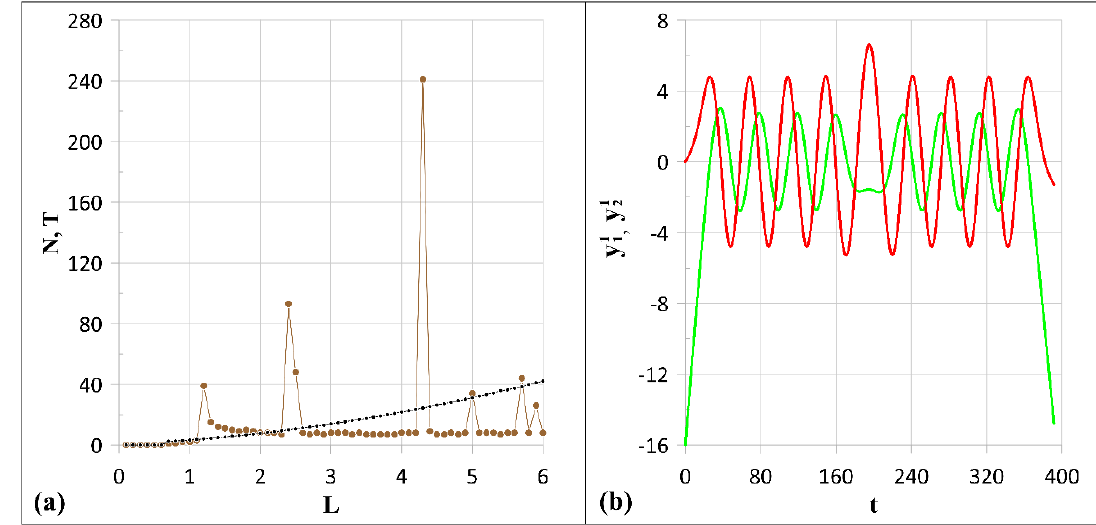
Figure 5. Some properties of the finite motion of vortices at 𝛬 21 𝛬 11 ⁄ = 1 2⁄ : ( a ) The average period T (violet line) of the vortex structure rotation and the number of rotations N (brown line) of the vortices in the closed region vs. the distance L . The curves are plotted according to calculations carried out at values of L with a step of 0.1 inside the interval [0.1; 6.0]. ( b ) Dependences of y -coordinates for the cyclone of the upper layer (red line) and for the cyclone of the middle layer (green line) at L = 4.8 in a time interval slightly exceeding the interval of finite motion of the vortices t ∈ [ 17.54;373.12 ] . For large values of N (for example, when L = 4.3 and N = 241, Figure 4f), there are several